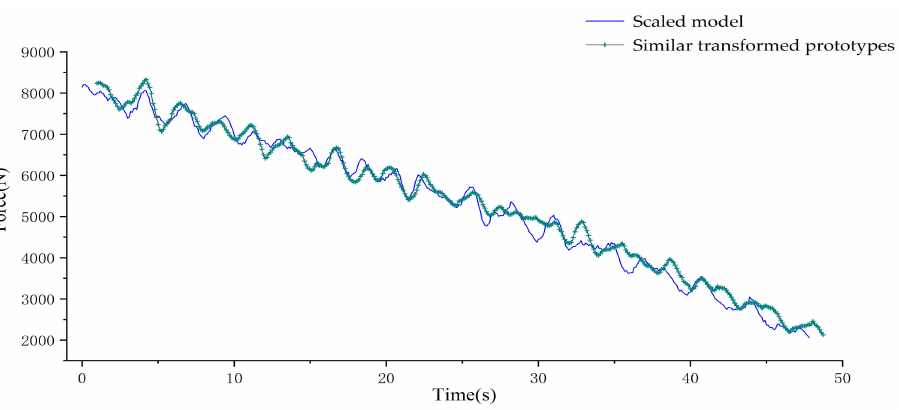
Figure 16. Force comparison diagram at the articulation of upper connecting rod of tower and tensioner